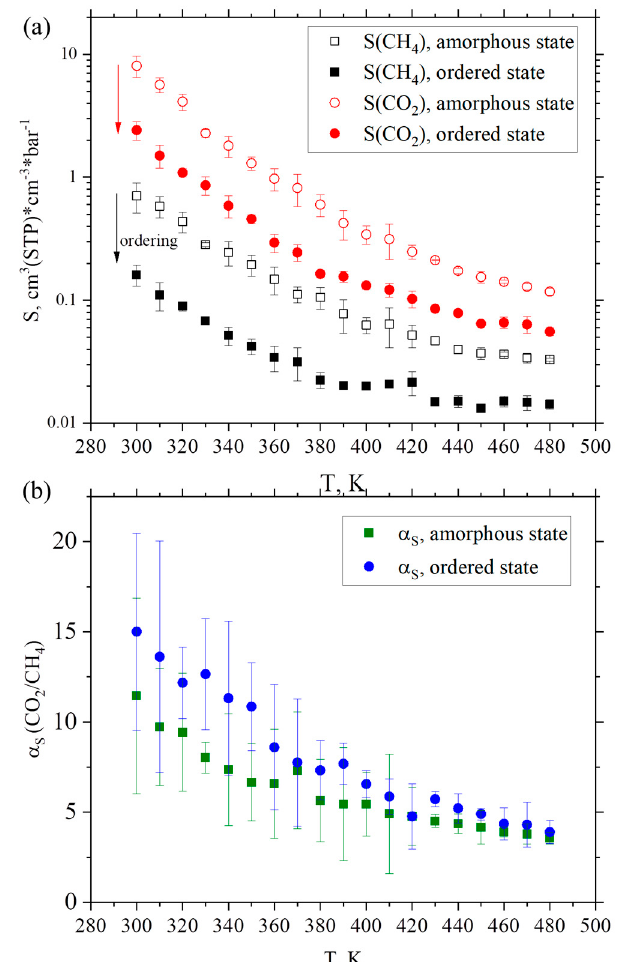
Figure 6. ( a ) Temperature dependence of solubility S for CH 4 (black squares) and CO 2 (red circles) gases in amorphous (open symbols) and ordered (filled symbols) states. ( b ) Temperature dependence of solubility selectivity α S for CH 4 /CO 2 pair in amorphous and ordered states.